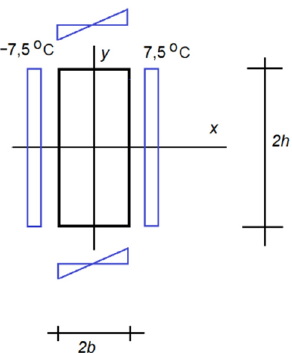
Figure 4. The symmetrical part of the task. SS state.